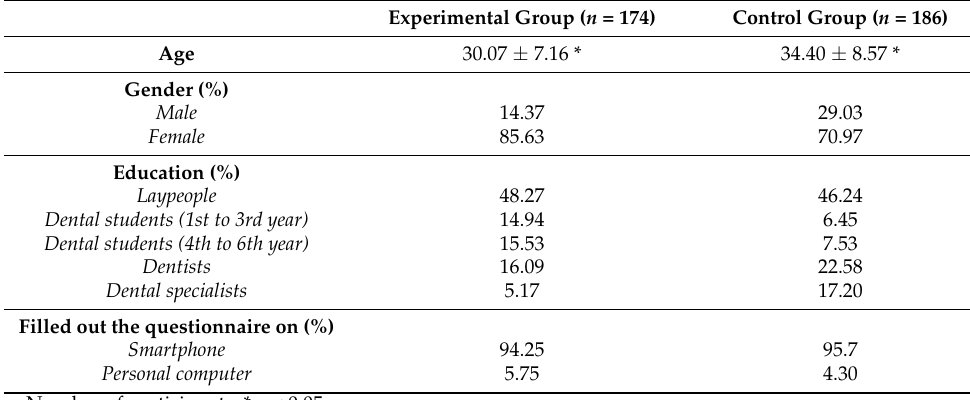
Table 1. Demographic and socioeconomic data of the